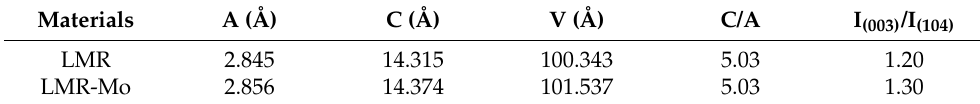
Table 1. Refined crystal parameters and relative diffraction peak ratios of LMR and LMR-Mo.